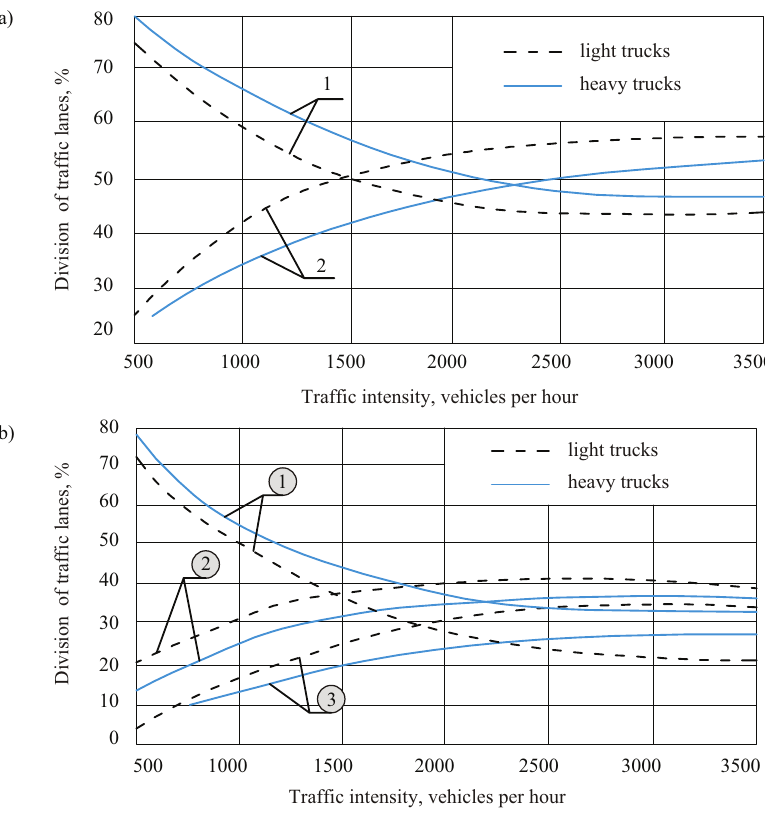
Figure 5. Percentage breakdown of traffic into lanes a) for a four-lane road: 1 – outer lane, 2 – centre lane, b) for six-lane road: 1 – outer